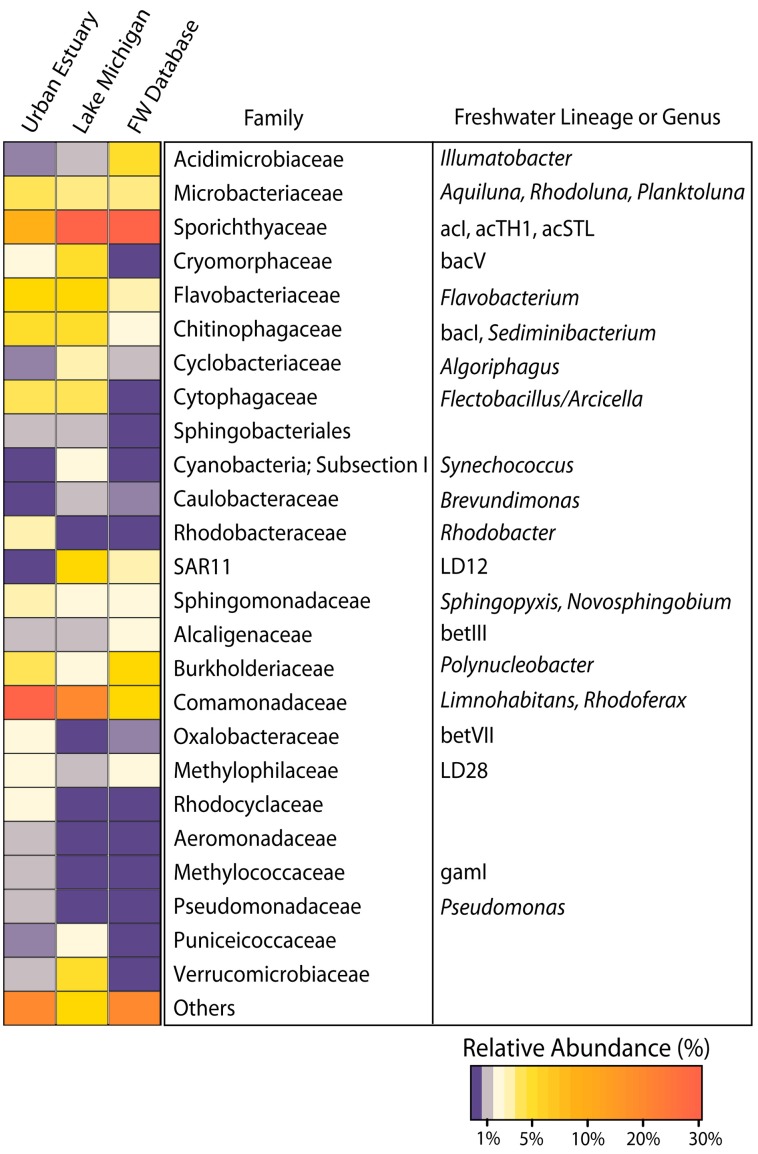
Heatmap indicating the relative abundance of all bacterial families with a mean relative abundance of ≥1% among either all Urban Estuary or all Lake Michigan samples. Common freshwater lineages as described in Newton et al. (2011a) are indicated with their respective family assignments. A previously compiled freshwater dataset is also depicted (FW Database) and consists of bacterial group distributions inferred from whole community 16S rRNA gene amplification and clone library construction across 47 lakes as described in Newton et al. (2011a).